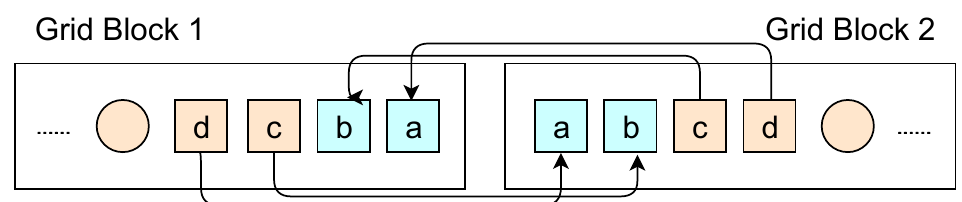
Figure 3. Ocean grid boundary